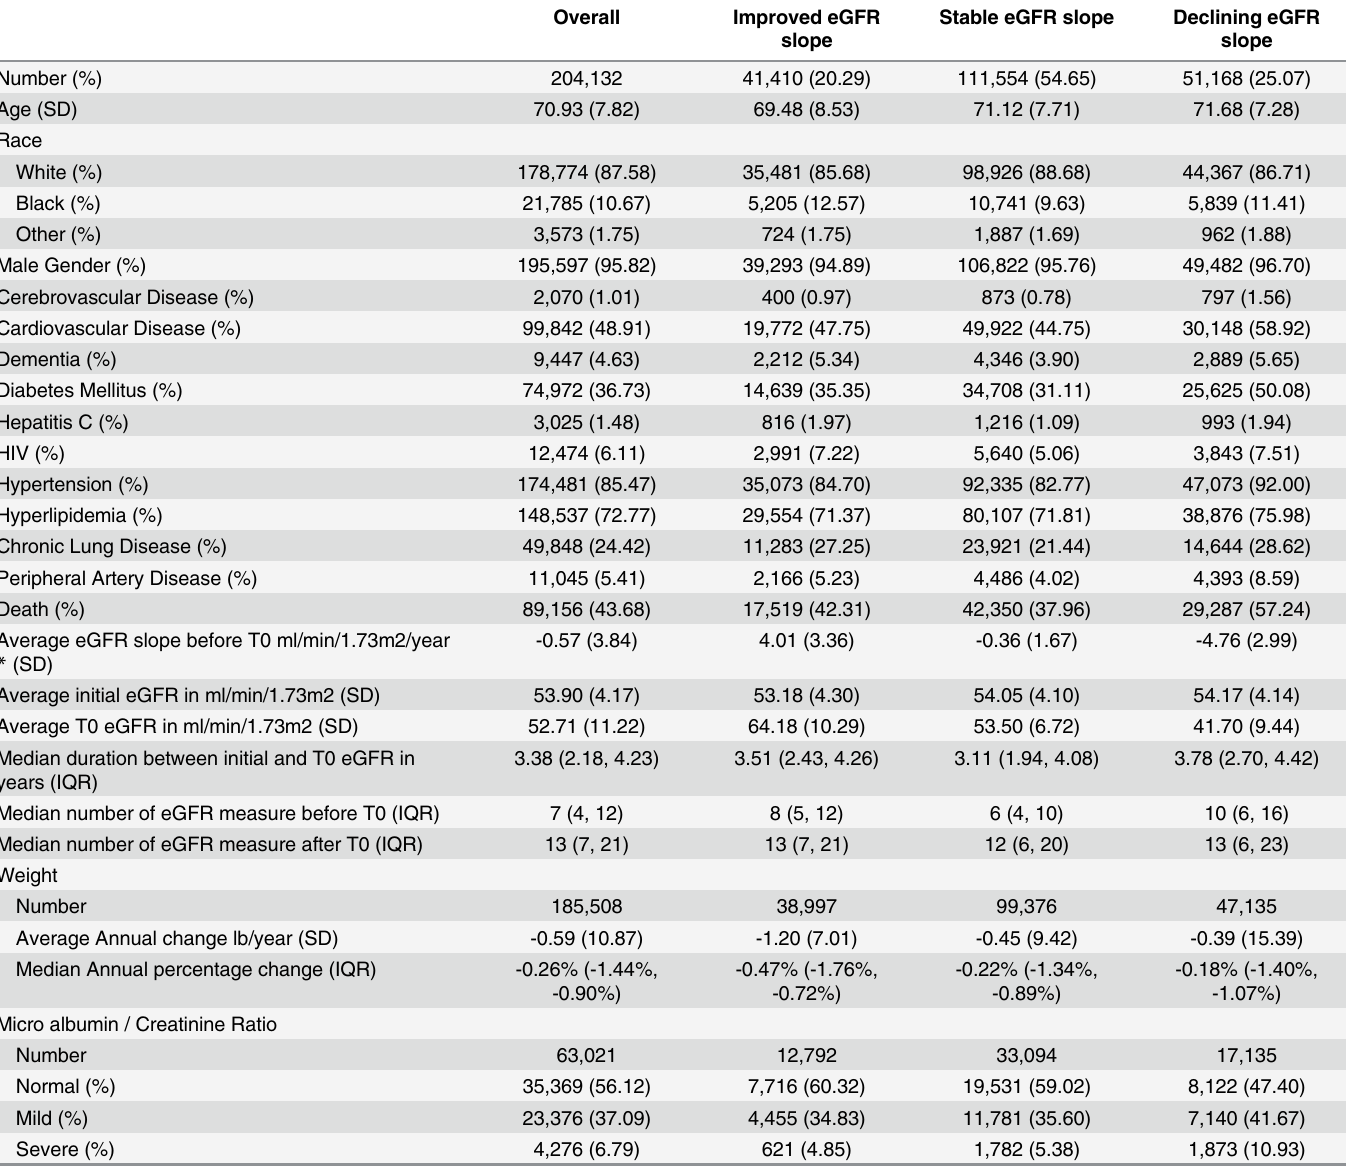
Table 1. Demographic and clinical characteristics of those with improved, stable, and declining eGFR